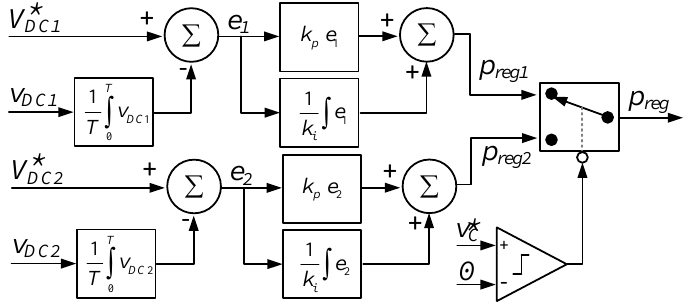
Figure 2. Block diagram of the DC-link voltage control algorithm.